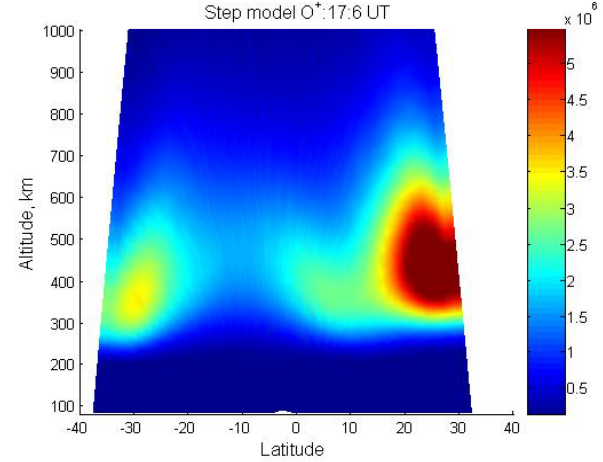
Fig. 2. Modeling of O + ion gravitational downdraft at 3h after the PPEF has been turned off. The color insets on the right of each panel show the local ion density in cm − 3 . Notice the maximum density has shifted from ∼ 620km to ∼ 430km in altitude and to higher latitudes.